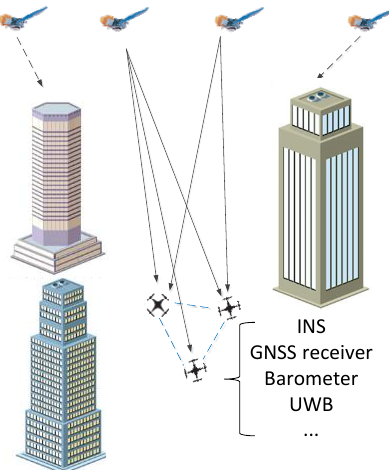
Figure 1. Cooperative navigation for UAV swarm in urban scenario.